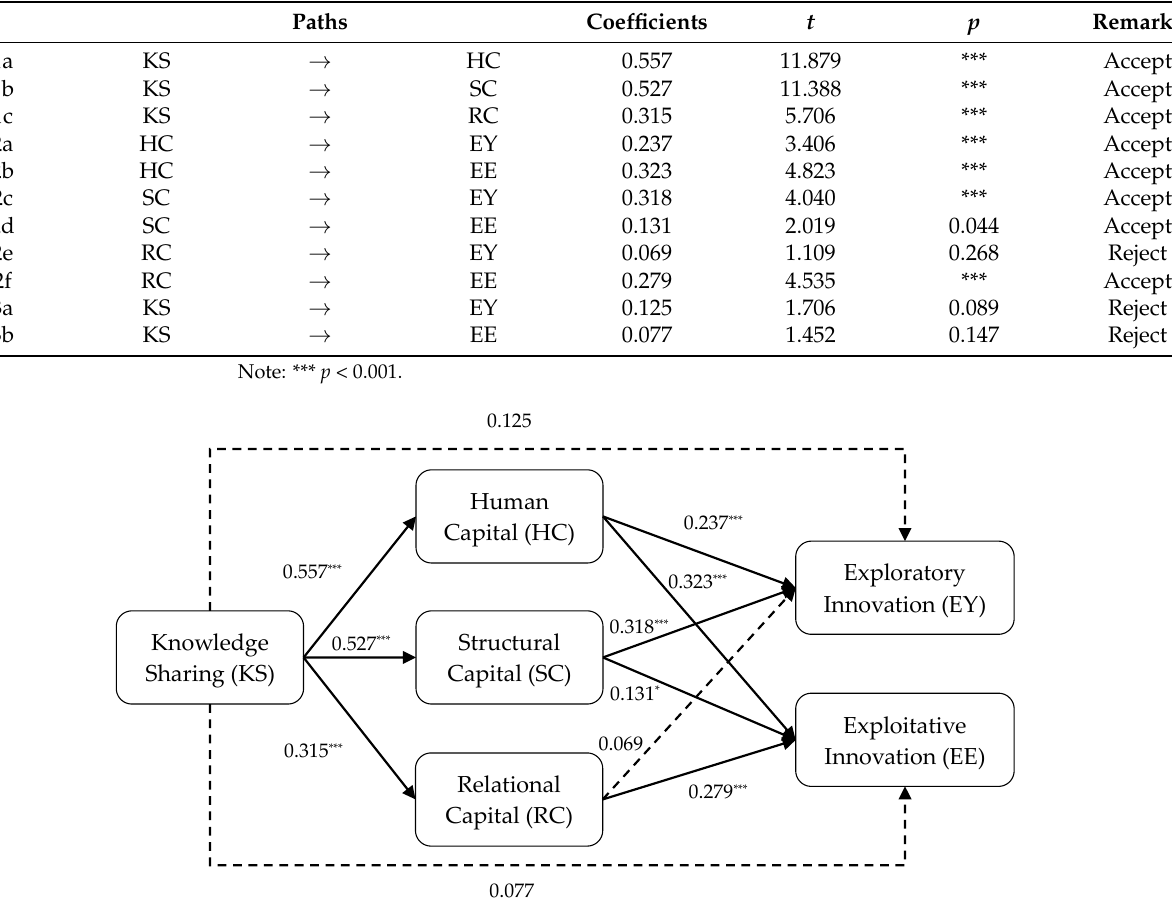
Figure 2. Research model and testing results. Note: * p < 0.05; *** p < 0.001. Table 5. Standardized path coefficients.